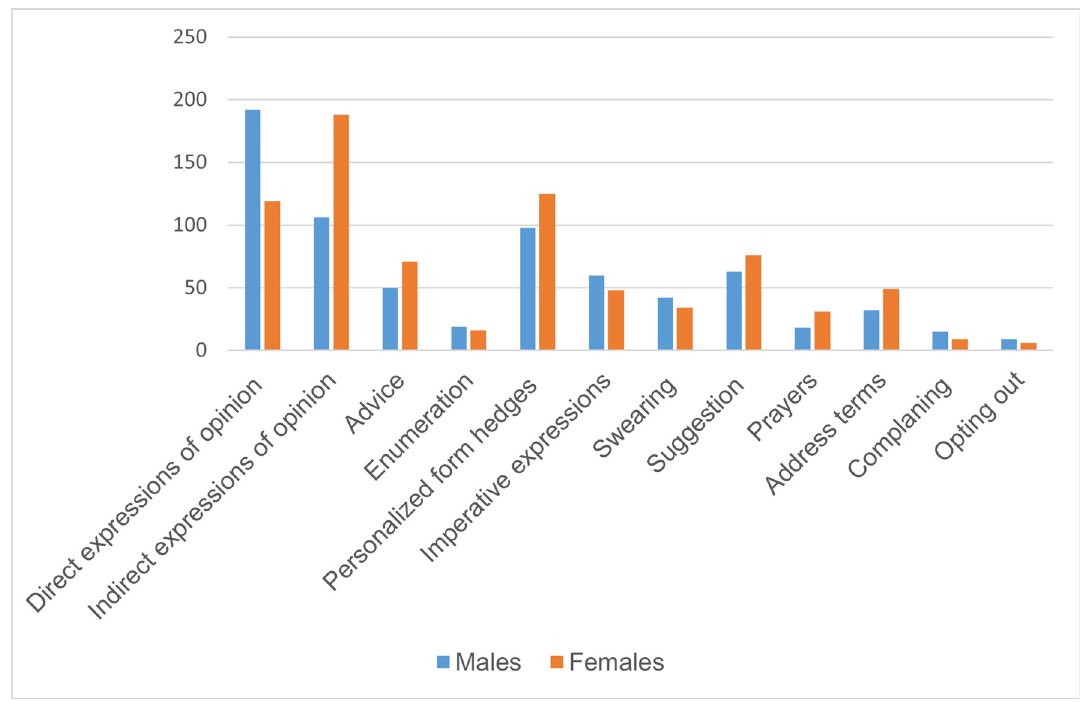
Figure 3: The frequency of the strategies used among male and female speakers of JA for expressing